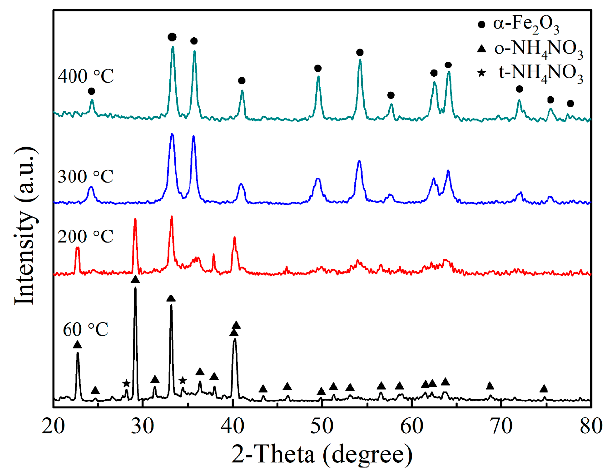
Figure 6. XRD patterns of the iron sol calcined at different temperatures for 1 h.